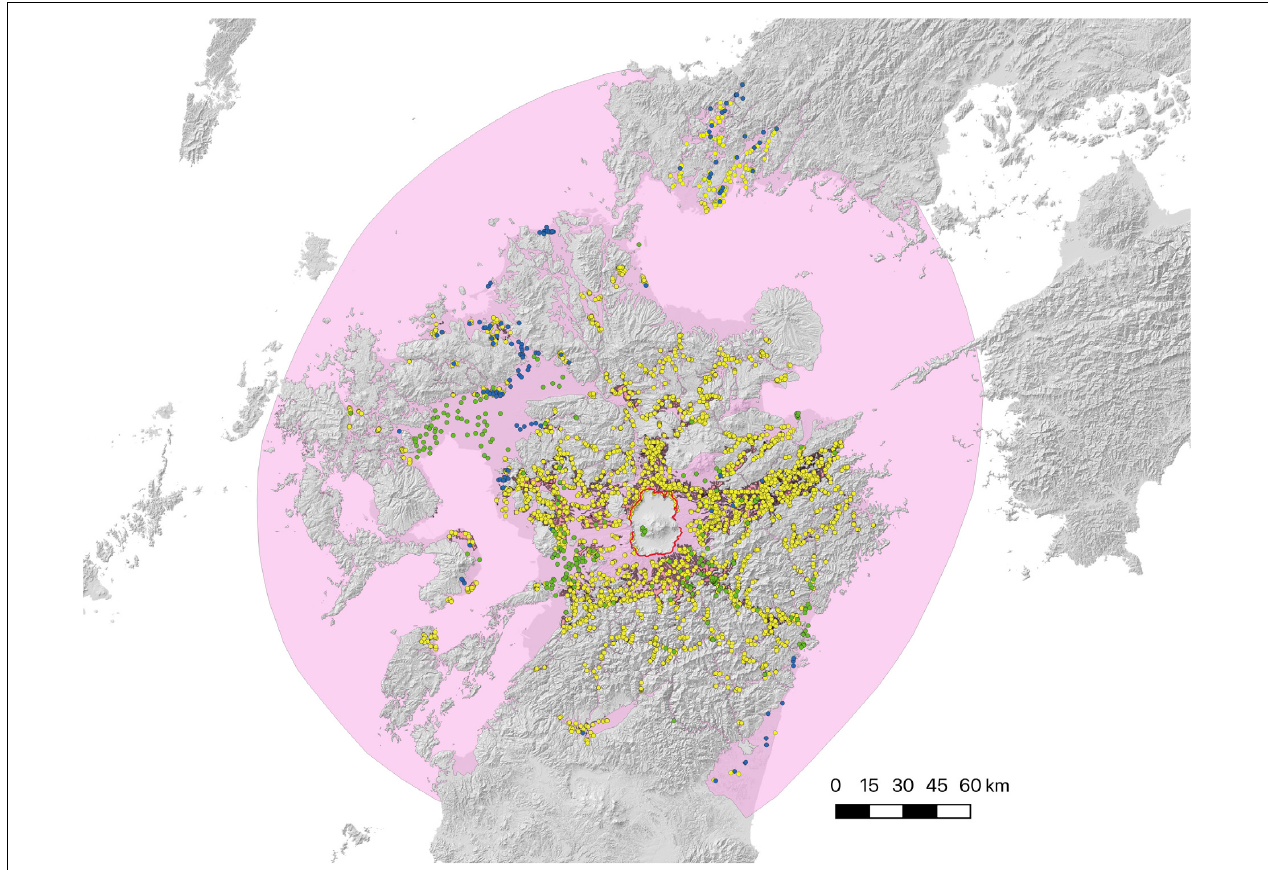
FIGURE 5 | Estimated original distribution of Aso-4 PDC deposit after the emplacement. Legends of circles on the map are the same as in Figures 1 , 4 . The Geospatial Information Authority of Japan (GSI) Tile Map (Shaded relief map) is used as the base